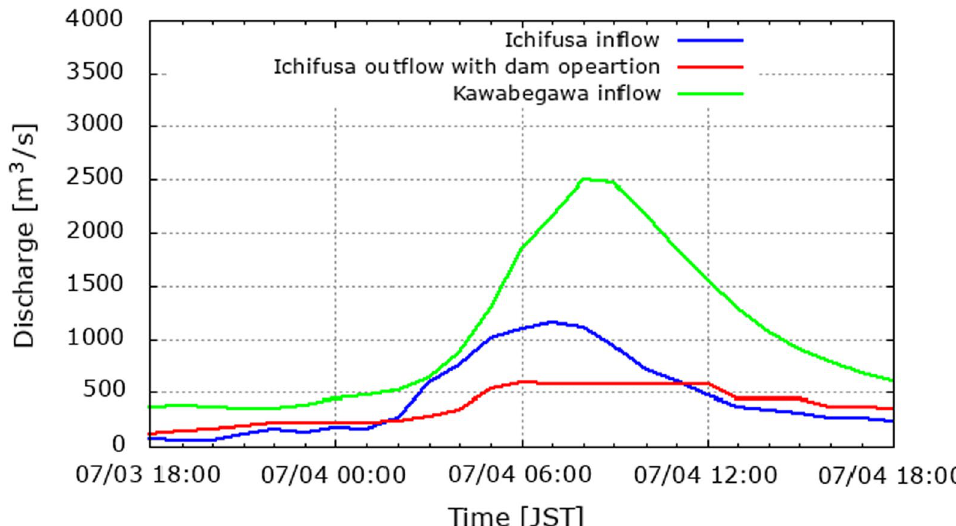
Fig. 4 Overview of the Kumagawa river catchment